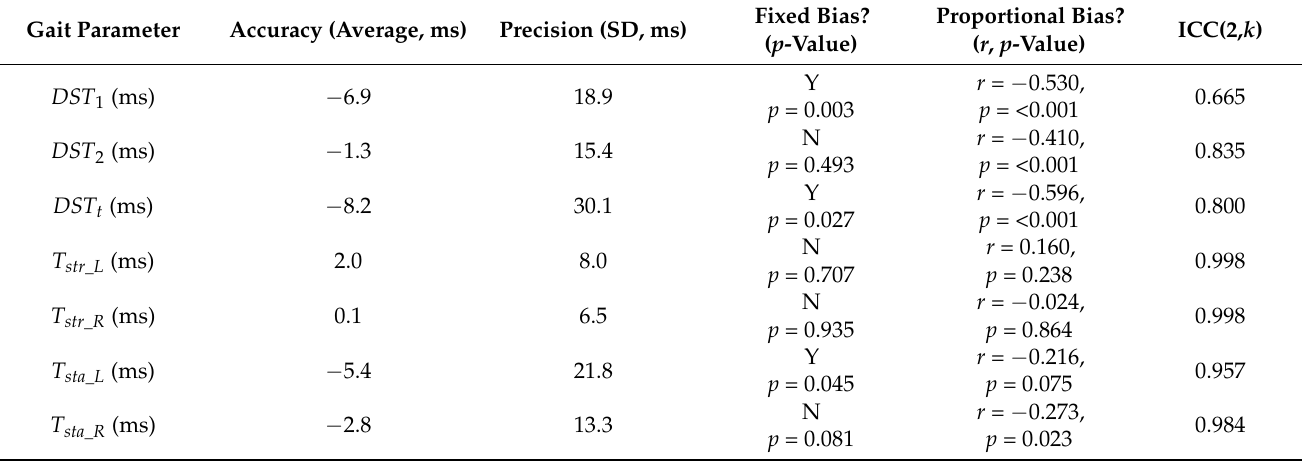
Figure 12. ( a ) Agreement plots between the IMS and Vicon results for gait parameters measured from five continuous effective strides, including DST 1 , DST 2 , DST t , T str_L , T str_R , SIS tr , T sta_L , T sta_R , and SIS ta . ( b ) Bland–Altman plots and LoAs of the 95% confidence interval around the PA line for comparison of the multiple-stride IMS and Vicon gait parameter measurement results. The black dashed lines are the PA lines, and each pair of black dotted lines represents the ULoA and LLoA. The LoAs of the parameters judged as having a proportional bias were corrected by a parametric approach via linear regression. Table 3. Accuracy and precision evaluation results for temporal gait parameters obtained by averag- ing five